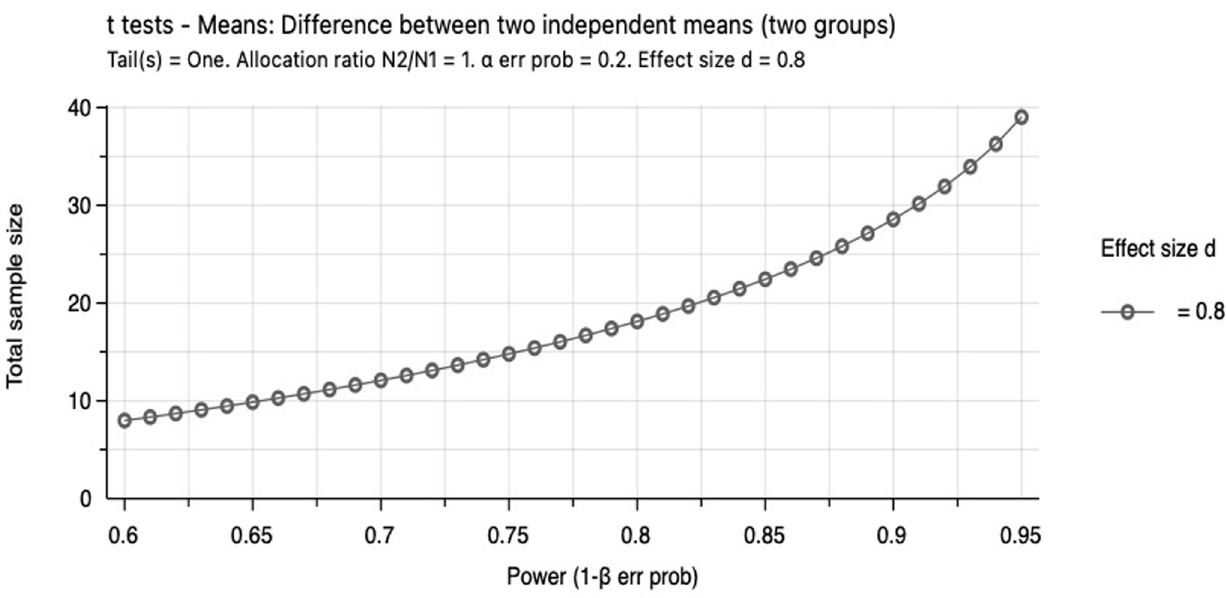
Fig 2. The calculation of sample size using G � Power analysis. Graphical representation of the distribution of power on X-axis versus total sample size on Y-axis.